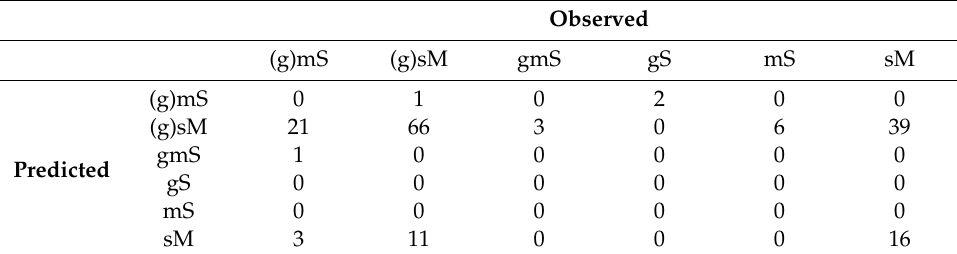
Table A4. Quantitative Folk S-LOO CV error matrix.